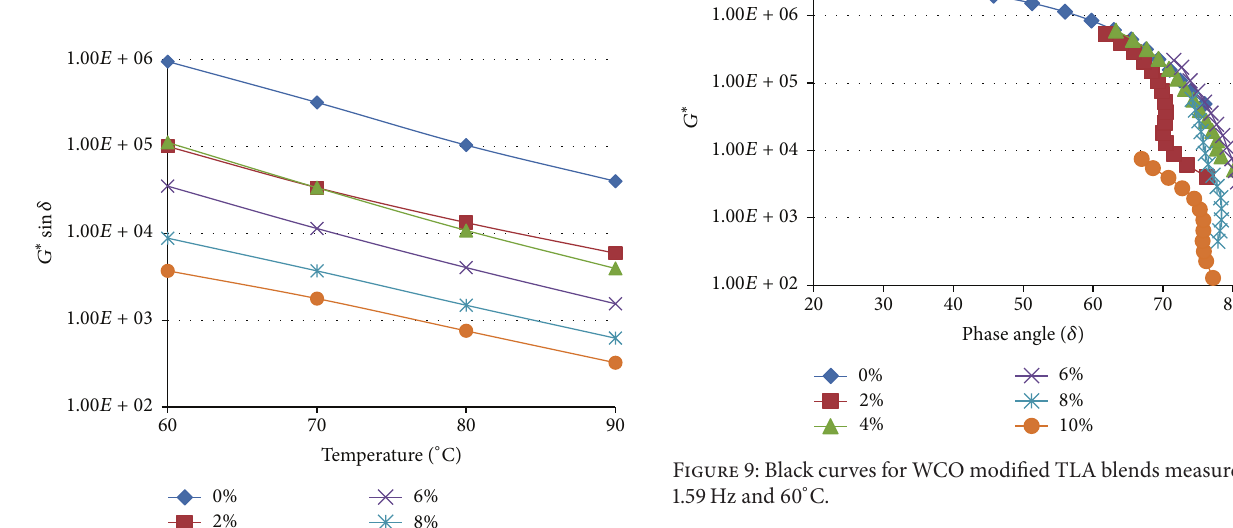
Figure 6: The variation of the rutting resistance parameter ( 𝐺 ∗ / sin 𝛿 ) with increasing concentration of WCO in TLA:TPB (50 :50) at various oscillating frequencies at 60 ∘ C.